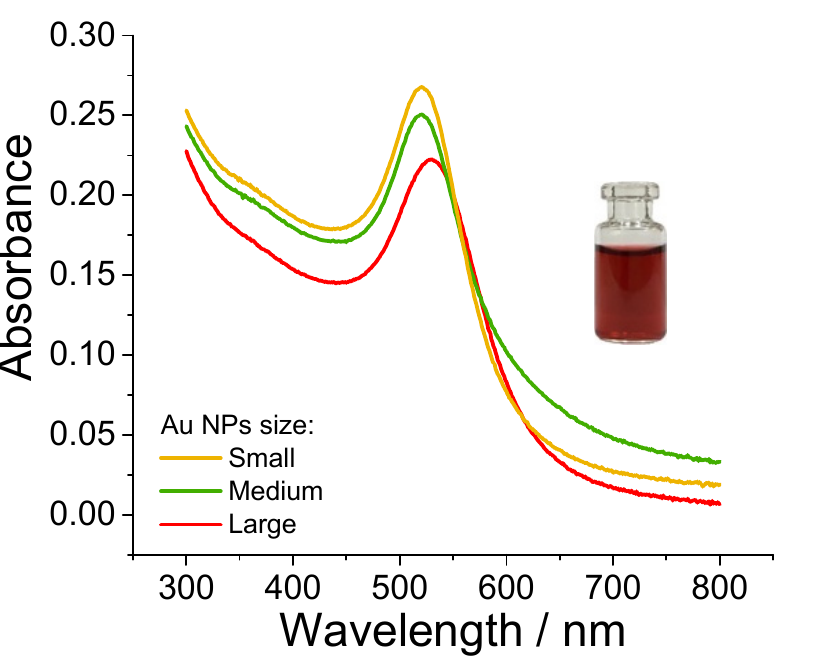
Figure 4. Absorbance spectra of small (Ø avg ~ 9 nm), medium (Ø avg ~ 14 nm), and large (Ø avg ~ 22 nm) AuNPs. Insets: as-synthesized red-wine colored AuNPs colloidal solution.